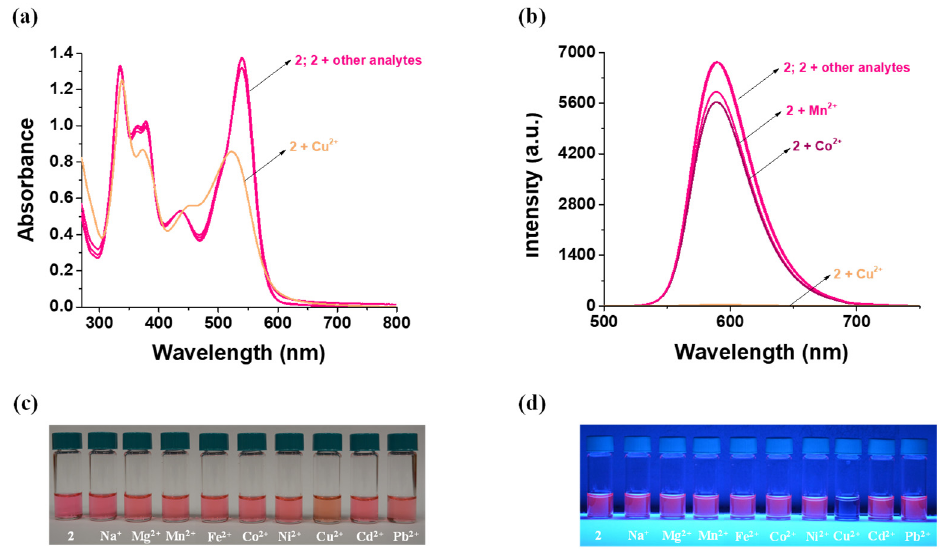
Figure 1. ( a ) UV-vis and ( b ) fluorescence ( λ exc = 421 nm) spectra of 2 (40 µ M solution in MeCN) before and after the addition of 2.0 equiv. of various metal cations. Photographs under natural light ( c ) and under 365 nm light ( d ) after the addition of 2.0 equiv. of various metal cations.